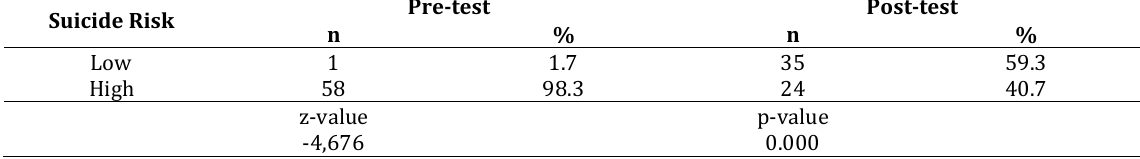
Table 3. Wilcoxon Test Statistics for Student Suicide Risk (N = 59) Suicide Risk